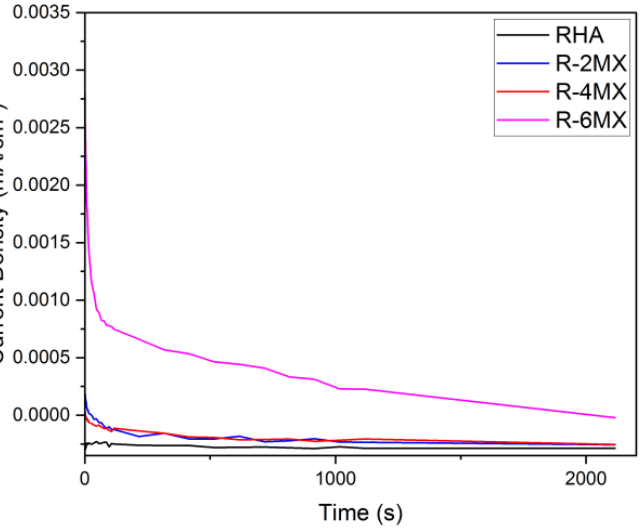
Figure 7. CA plot of RHA and MXene with different weight percentages of composites. Table 2. Retention rates of electrocatalysts obtained through CA analysis.